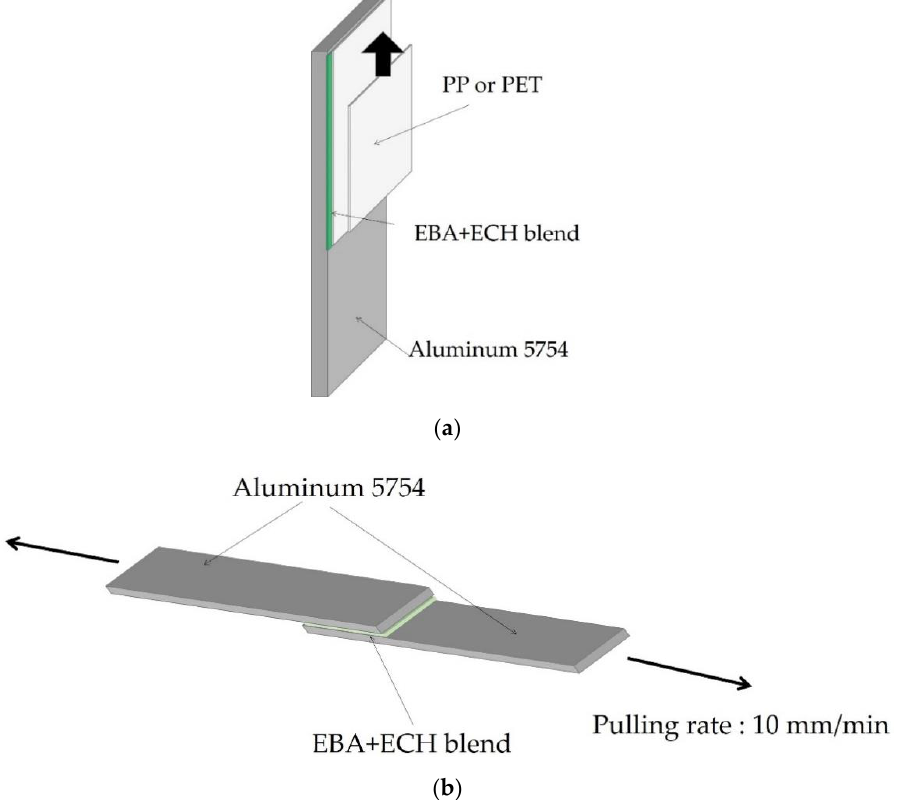
Figure 2. ( a ) Scheme of the test sample for 180° peel test and ( b ) scheme of the test sample for single lap-shear test.